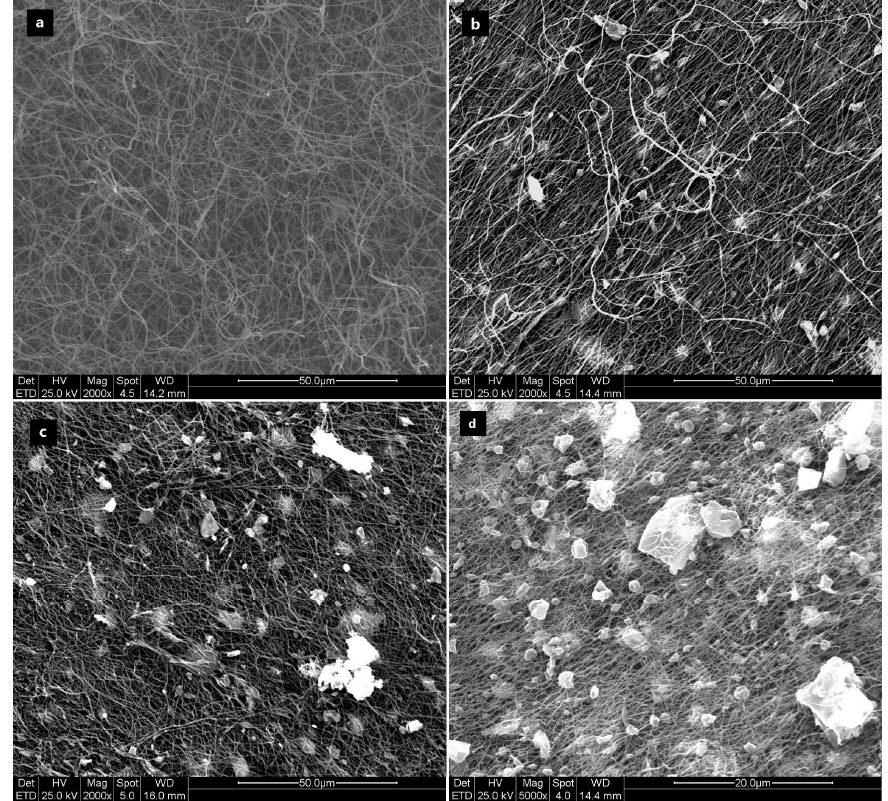
Figure 6. ESEM imaging of the carbonized fibers: ( a ) 100% PAN; ( b ) 90% PAN-10% biochar; ( c ) 75% PAN-25% biochar; ( d ) 50% PAN-50% biochar.